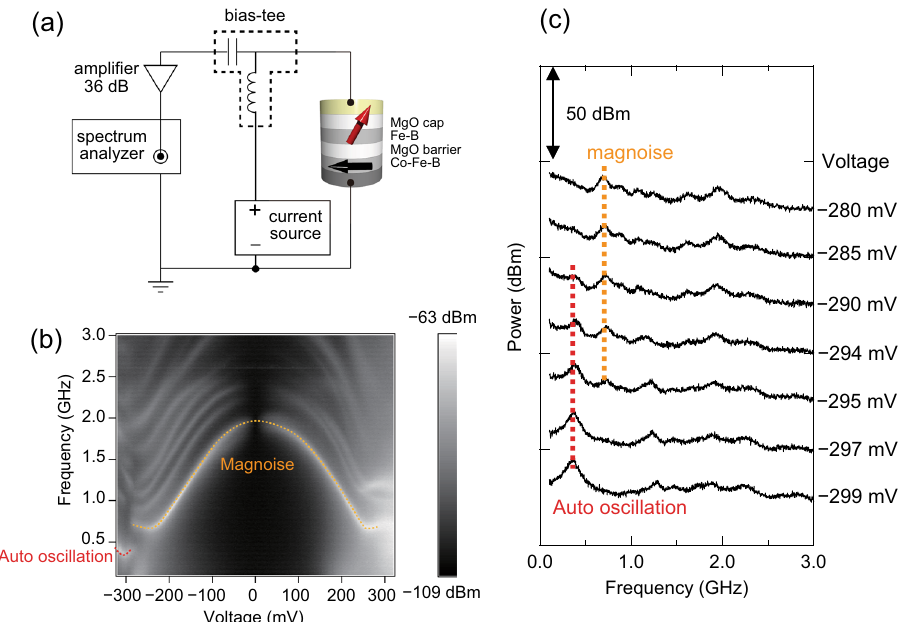
Fig. 4 Noise power spectrum measurement. a Schematic of measurement circuit used for noise power spectrum. b Color mapping of bias-voltage dependence of noise power spectrum. The resolution bandwidth is 5 MHz. c Noise power spectra in the bias-voltage range of − 280 to − 299 mV. In both ( b ) and ( c ), dashed yellow and red lines represent the peak frequency due to magnoise and spin-torque auto-oscillation, respectively. These are drawn in free hand as a guide for the eye.